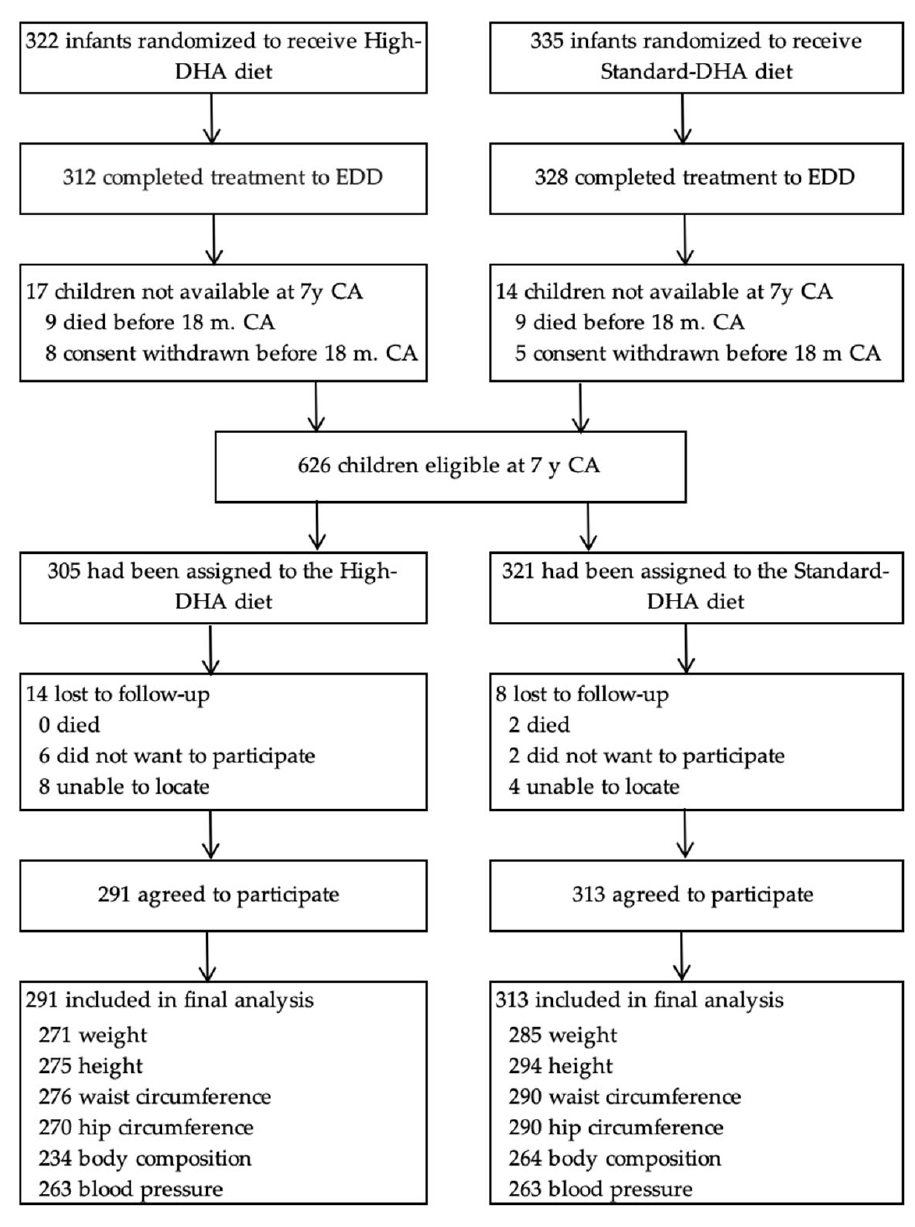
Figure 1. Participant flow and follow ‐ up.